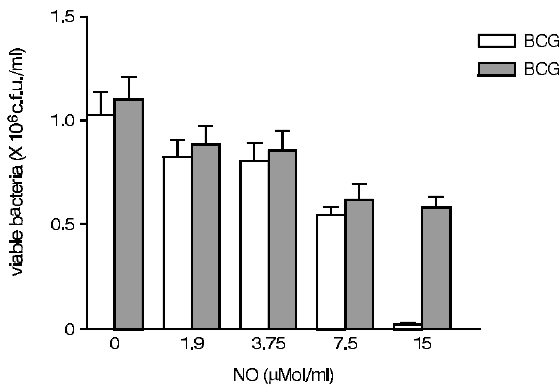
FIG. 7. Susceptibility of BCG bacilli to nitric oxide (NO): 1.5 ´ 10 6 colony-forming units of BCG-I or BCG-S were exposed to different amounts of NO for 24h. The number of viable BCG-I or BCG-S was assessed as described in Materials and Methods. Each point represents the values of samples from five experiments ± standard deviation in different groups of five